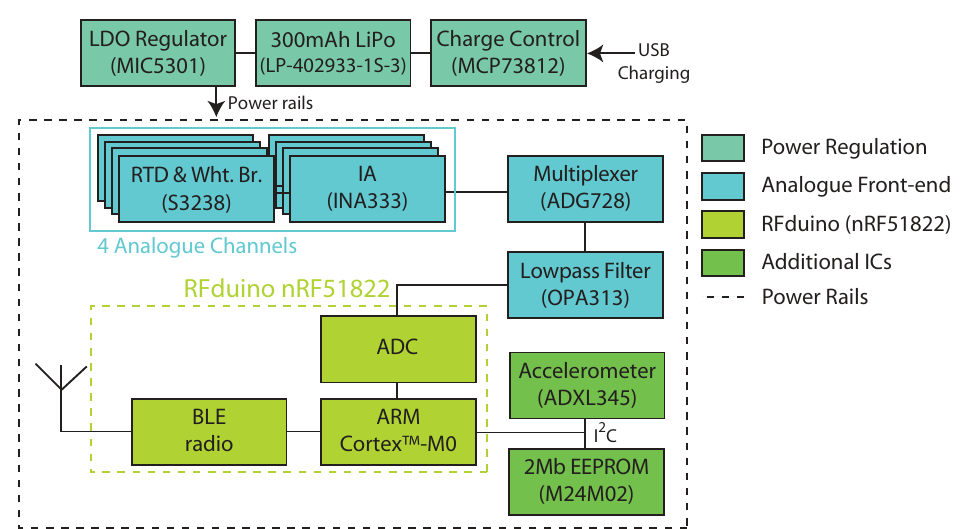
Figure 1. Block diagram of the main electronic components in the smart insole system developed in this work. Lines denote signal flow between components of the schematic. Abbreviations: Low Dropout (LDO), Resistance Temperature Detector (RTD), Wheatstone Bridge (Wht. Br.), Instrumenta- tion Amplifier (IA), Analogue-to-Digital Converter (ADC), Bluetooth Low Energy (BLE), Electrically Erasable Programmable Read-Only Memory (EEPROM).